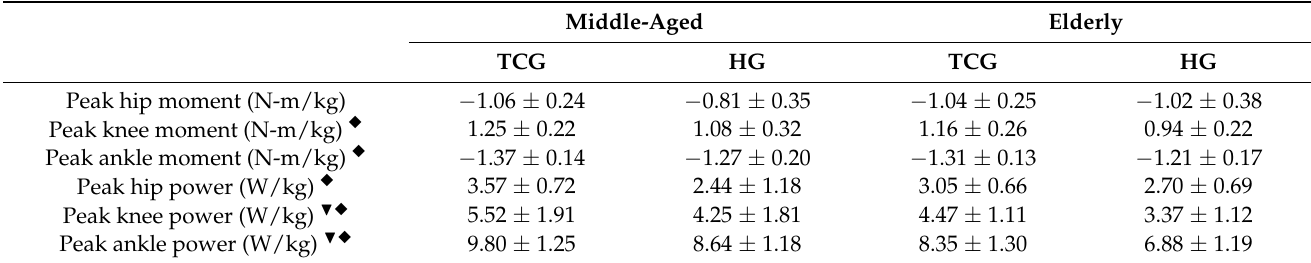
Table 2. Joint dynamic during take-off phase. Middle-Aged Elderly TCG HG TCG